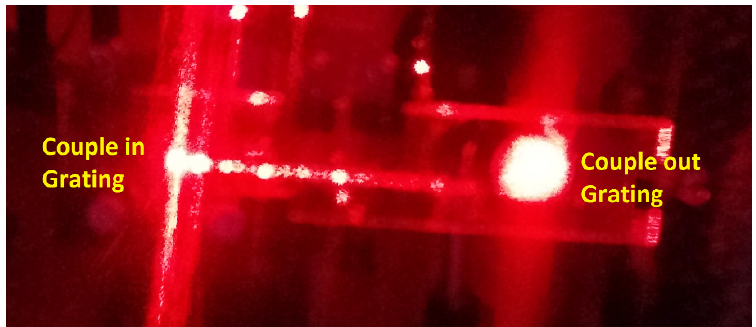
Figure 10. Recorded waveguide under illumination.